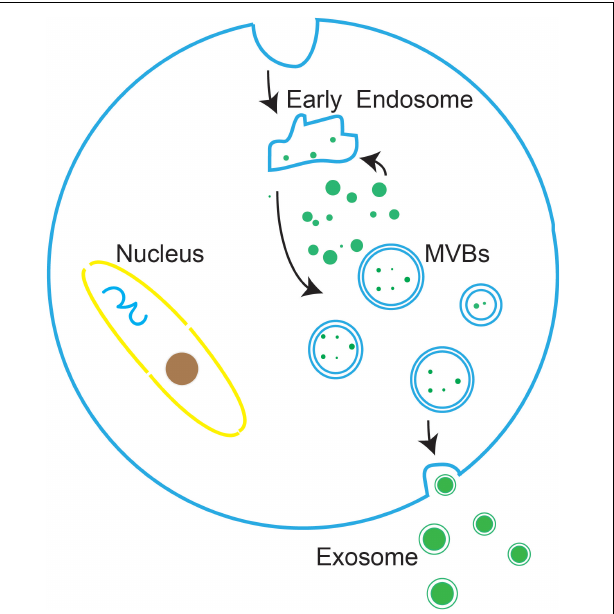
FIGURE 1 | The biogenesis of exosomes. the plasma membrane invaginated to produced endocytic vesicles, which are further transformed into MVBs. MVBs then move and touch to the plasma membrane to secrete vesicles into the extracellular environment, at which point the vesicles are defined as